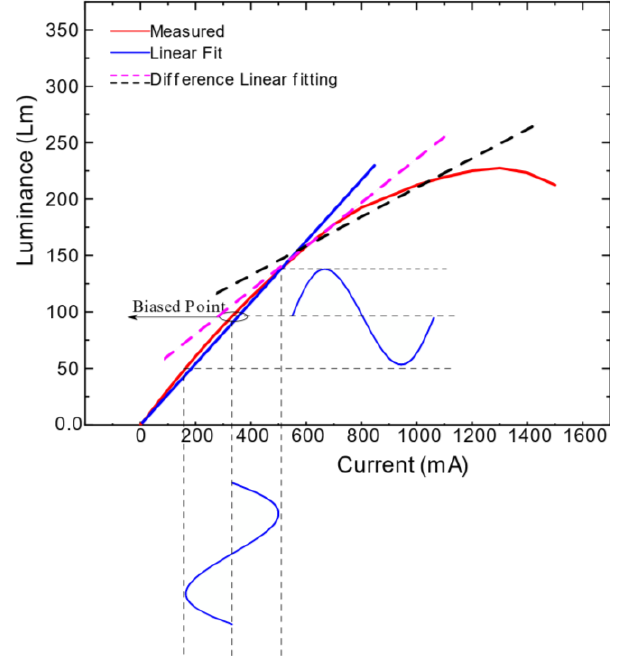
Figure 1. Nonlinear LED transfer function.